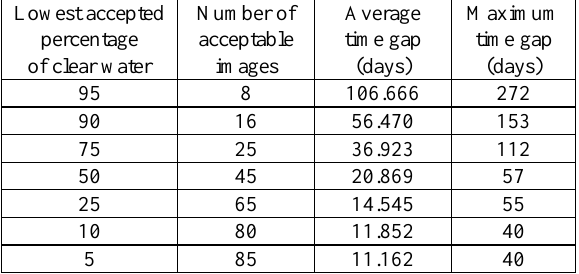
Table 1. Real time gap according to acceptable percentage of clear water